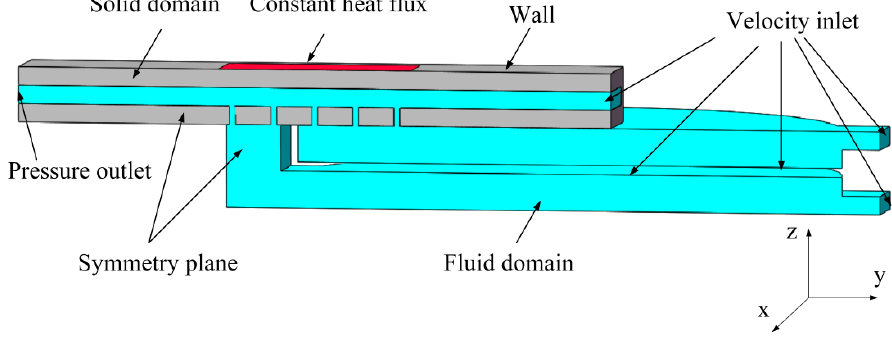
Figure 3. Boundary conditions of the calculation model.